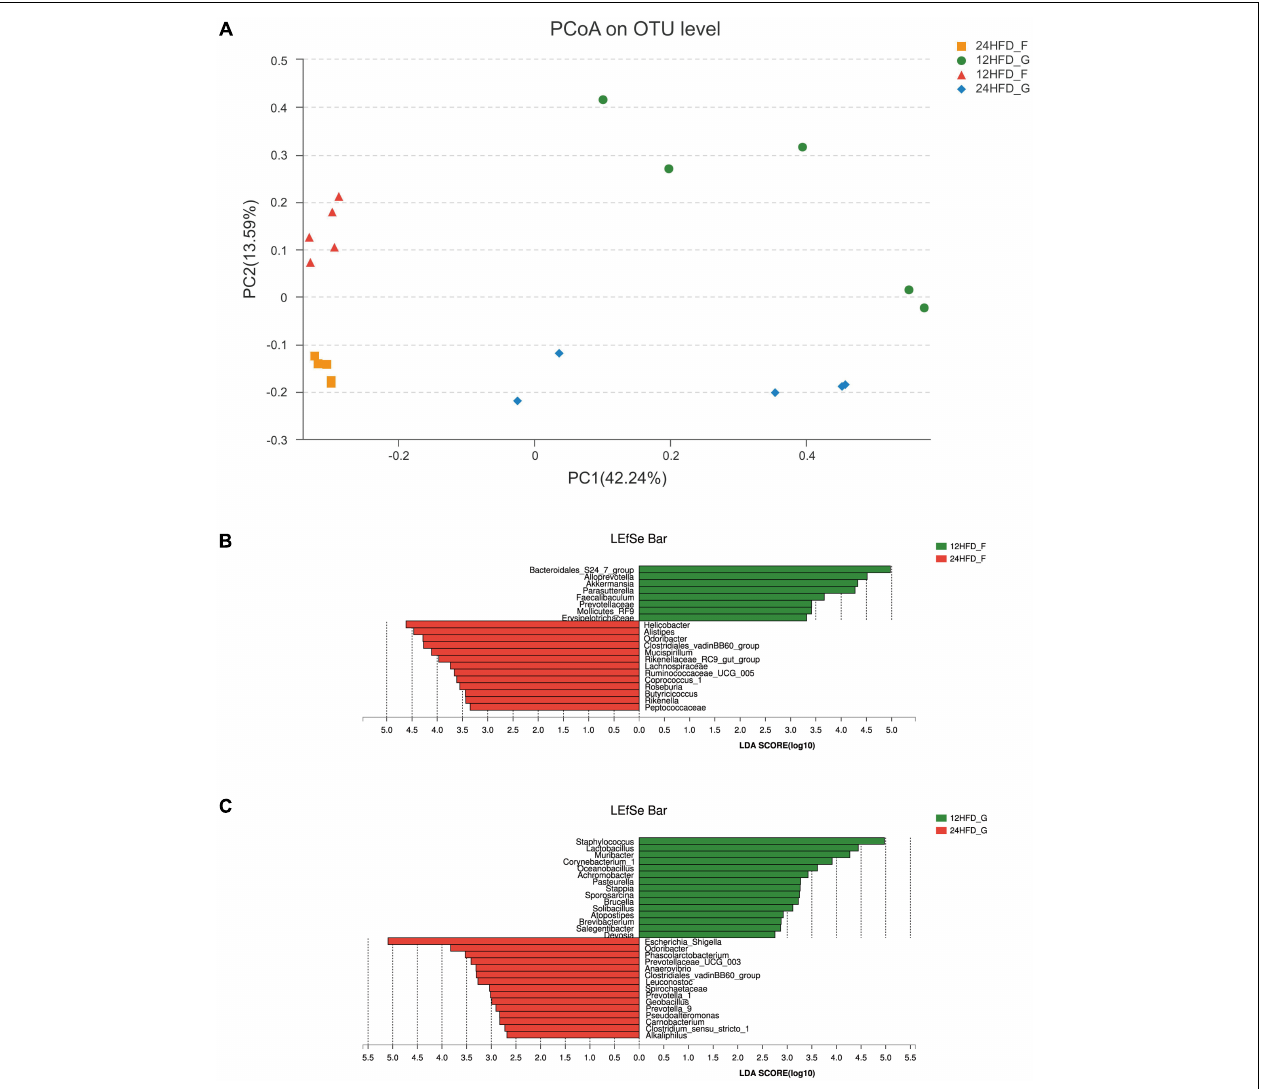
FIGURE 3 | The alteration of gastric (G) and gut (F) microbiota in mice fed HFD after different periods. (A) Beta diversity as revealed by PCoA analysis based on the Bray–Curtis distance showed that the samples of 12 weeks (12HFD_G and 12HFD_F) clustered separately from those of 24 weeks (24HFD_G and 24HFD_F). LEfSe analysis was used to identify the most differentially abundant taxa between 12HFD_F and 24HFD_F (B) as well as 12HFD_G and 24HFD_G (C) . The enriched taxa in mice given HFD for 24 weeks were indicated in red while taxa enriched in those given HFD for 12 weeks were represented in green. Only taxa meeting an LDA significant threshold of > 2 were